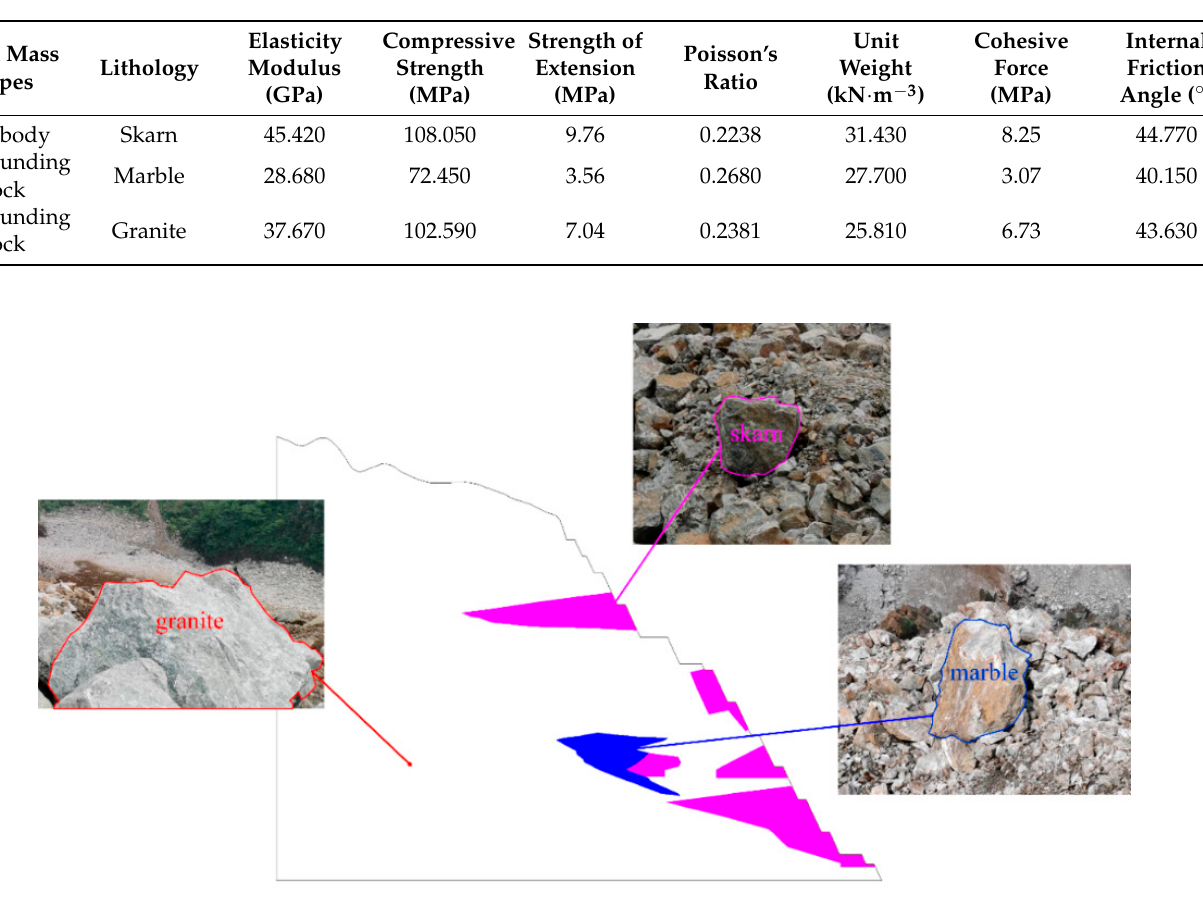
Table 1. Rock mechanics parameters of slope rock after engineering reduction.